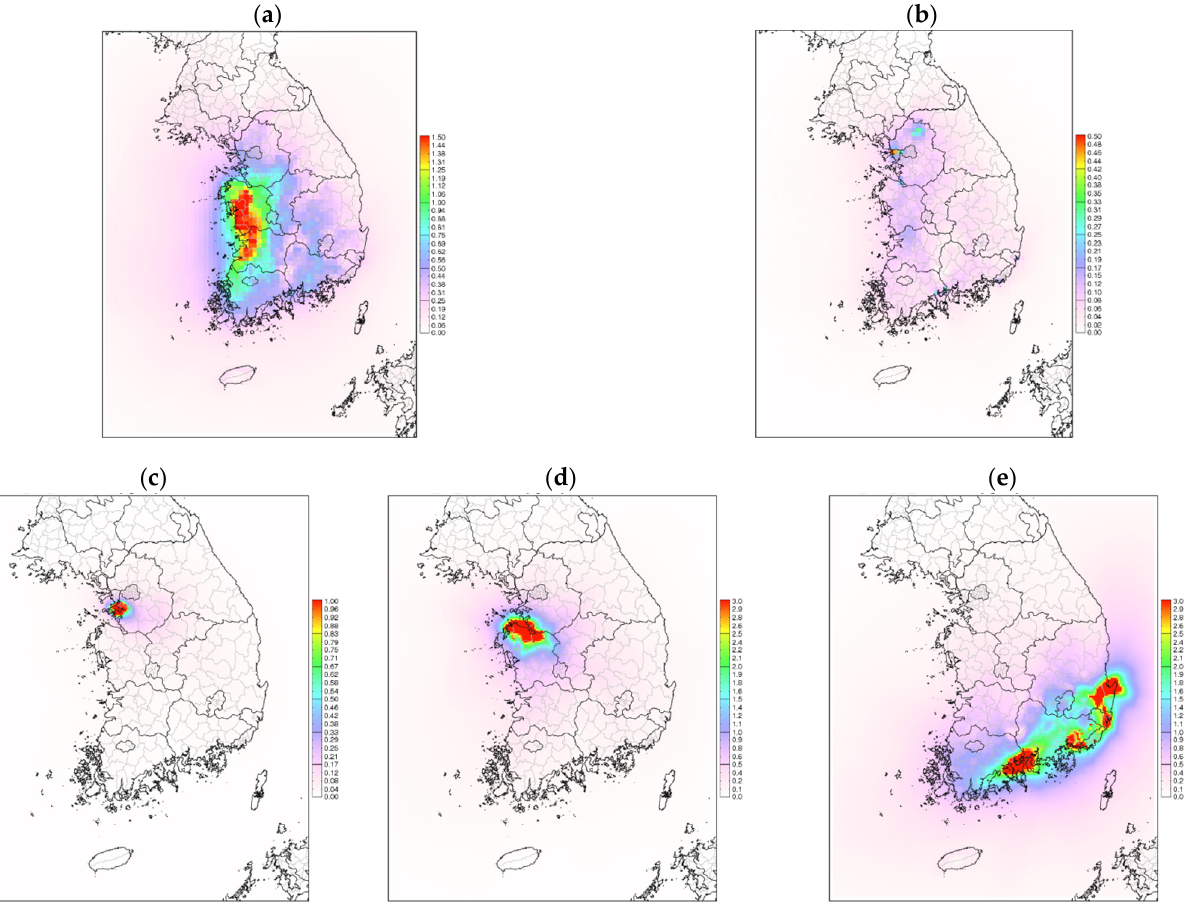
Figure 4. PM 2.5 contribution concentrations from emissions of ( a ) coal power plants; ( b ) LNG power power plants; ( c ) the Sihwa-Banwol Industrial Complex; ( d ) the Daesan Petrochemical Complex; and plants; ( c ) the Sihwa ‐ Banwol Industrial Complex; ( d ) the Daesan Petrochemical Complex; and ( e ) NICs that fall under the Special Measures Area for Preventing Air Pollution. ( e ) NICs that fall under the Special Measures Area for Preventing Air